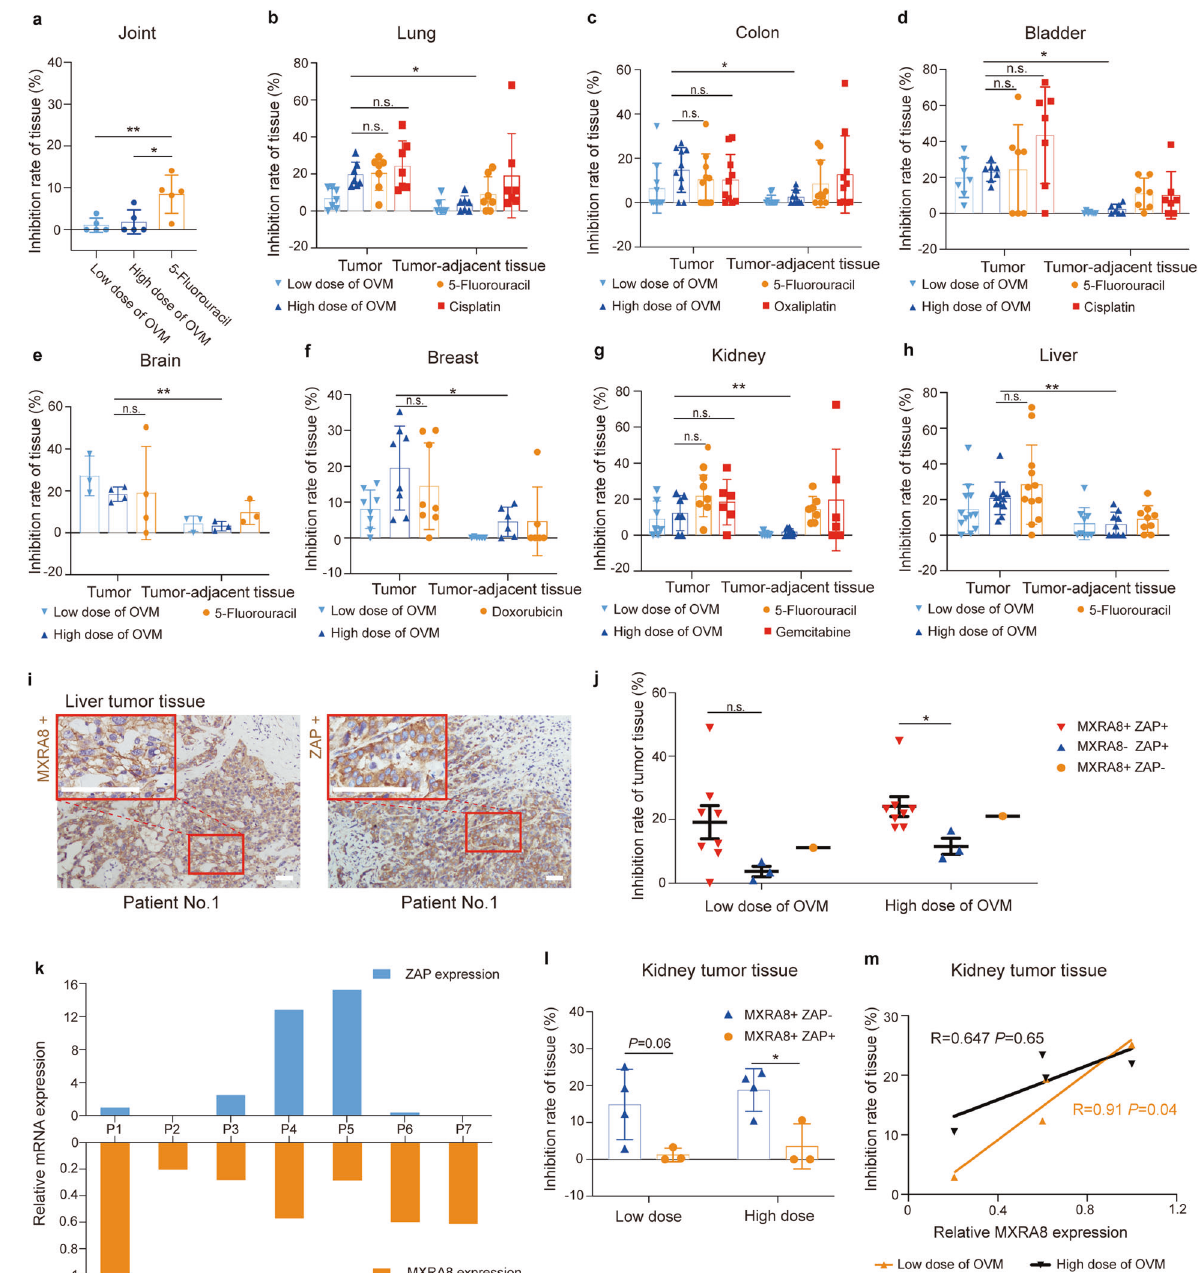
Fig. 6 High MXRA8 expression and ZAP de fi ciency promote the oncolysis of OVM in patient-derived tumor tissues. a Inhibition rate of joint tissue treated with OVM and 5-Fluorouracil ( n = 5). b – h , Inhibition rate of tumor tissue and tumor-adjacent tissue in lung ( n = 7), colon ( n = 8), bladder ( n = 7), brain ( n = 4), breast ( n = 8), liver ( n = 12), and kidney ( n = 7) treated with OVM, 5-Fluorouracil, Cisplatin, Oxaliplatin, Doxorubicin, and Gemcitabine respectively. Each dot represents a single patient. Data were analyzed by one-way ANOVA. i Representative image cores of MXRA8 and ZAP positive immunostaining in liver tumor tissue. Image of higher magni fi cation was shown in box. Scale bars, 50 μ m. j Liver tumor tissue inhibition rate of groups of patients with different ZAP and MXRA8 expression (two-tailed unpaired t -test; mean ± s. d.). k Relative ZAP and MXRA8 mRNA expression of each kidney tumor tissue measured by qPCR. l Comparison of inhibition rate of kidney tumor tissues with high ZAP or low ZAP expression (two-tailed unpaired t -test; mean;± s.d.). m Correlation of inhibition rates and MXRA8 expression levels in kidney tumor tissue with MXRA8 expression and ZAP de fi ciency. R indicates the Pearson correlation coef fi cient. * P < 0.05; ** P < 0.01; *** P < 0.001 and ZAP in liver tumor tissues by IHC (Fig. 6i). The data showed Compared to the group with high ZAP expression, tumor that OVM had a better oncolysis on liver tumor tissues with inhibition rate in MXRA8 + /ZAP − was signi fi cantly increased under MXRA8 positive staining compared to tumor with no MXRA8 high dose of OVM treatment (Fig. 6l). Moreover, by controlling the expressing (Fig. 6j). Similarly, by using RT-qPCR, seven kidney inhibitory impact of ZAP in kidney tumor, MXRA8 expression tumor patients were divided into MXRA8 + /ZAP − (patient No. 1, 2, showed an obvious positive correlation with the sensitivity of tumor tissues to OVM treatment (Fig. 6m). 6, and 7) or MXRA8 + /ZAP + (patient No. 3, 4, and 5) group (Fig. 6k). Signal Transduction and Targeted Therapy (2022)